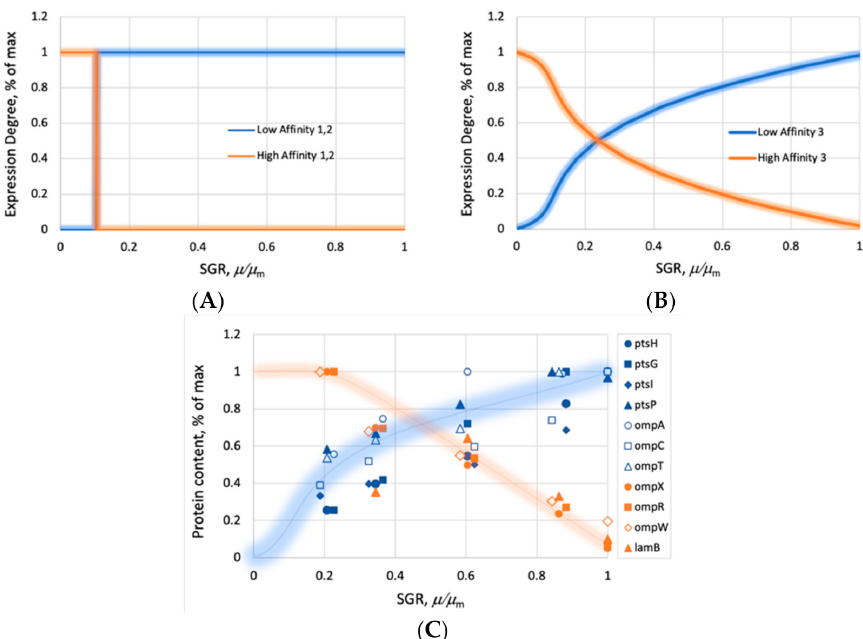
Figure A4. Simulation of conditionally expressed glucose transporters using three methods. ( A ) The optimality and Boolean approaches (results turned out identical). ( B ) Expression predicted by the SCM/FBA hybrid model. ( C ) E. coli proteomic data [156]. Blue and orange curves and symbols are applied, respectively, to the low and high affinity